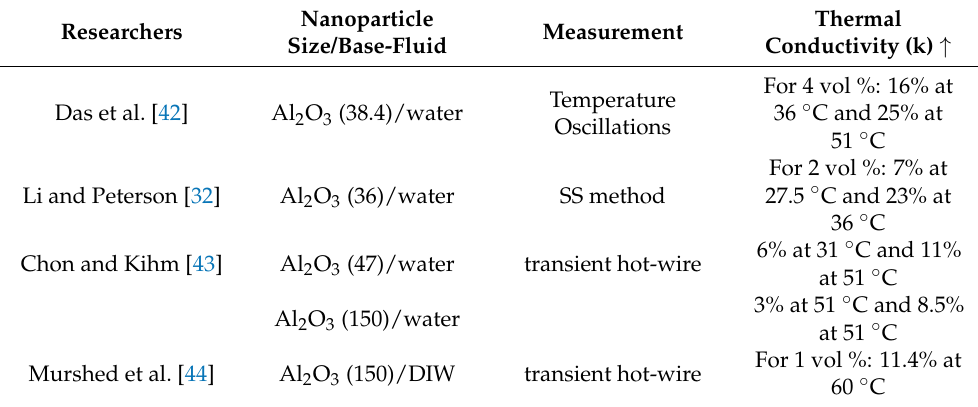
Table 2. The Influence of Temperature on